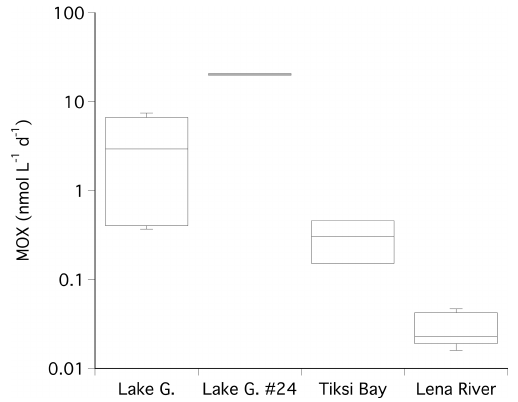
Figure 4. Box plot of the calculated methane oxidation rates (MOX) in water under ice cover at Lake Golzovoye, at the location of ice core no. 24, Tiksi Bay, and the Lena River. Note the logarithmic scale.